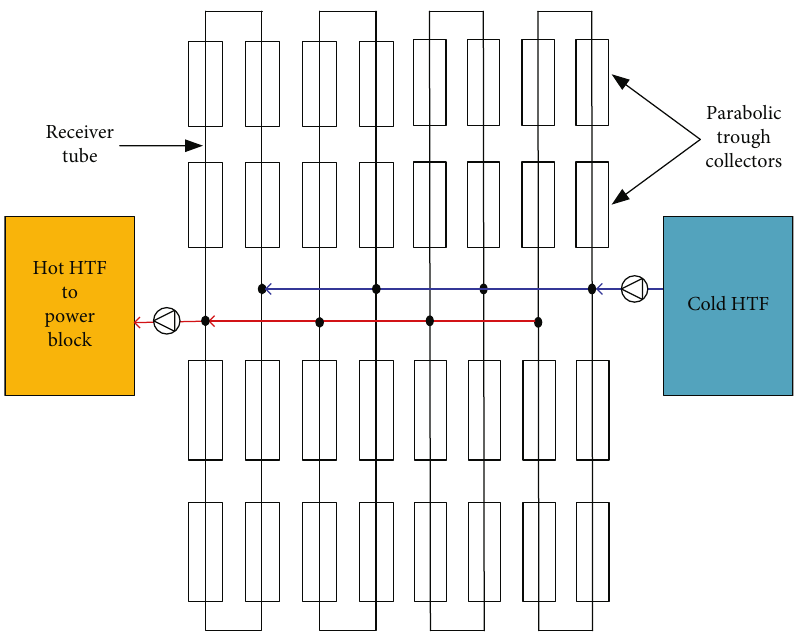
Figure 1: Parabolic trough solar fi eld con fi guration [34].